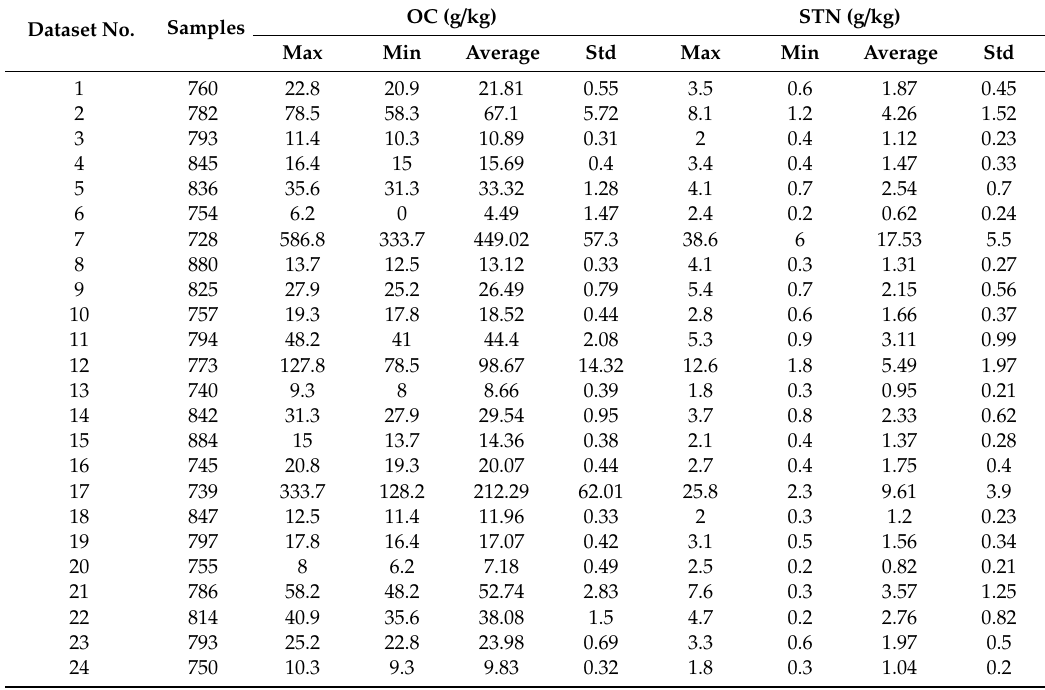
Table 7. Description of the datasets with di ff erent organic carbon (OC) content. Dataset